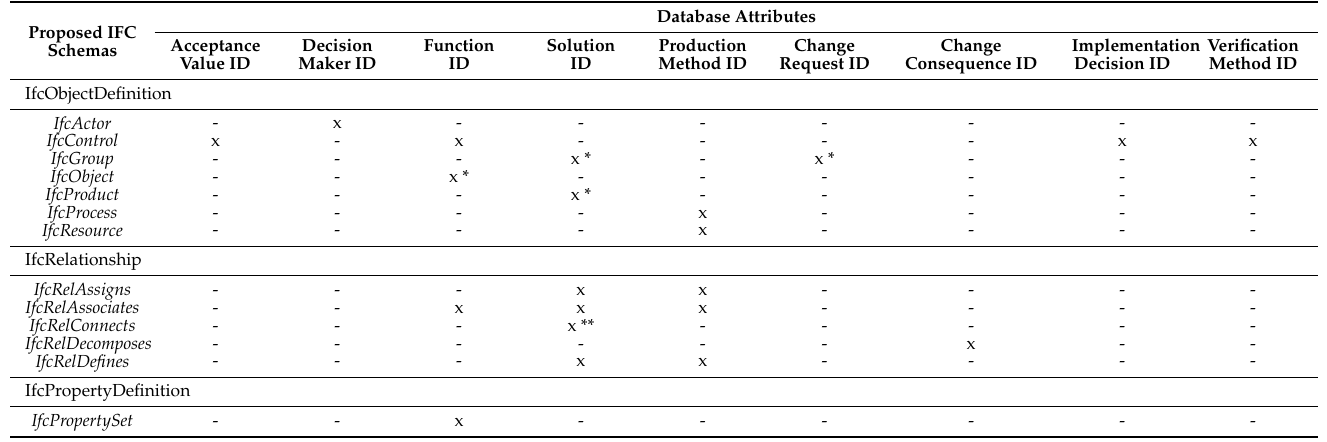
Table 3. The proposed IFC schemas for each attribute in the ER model and the ones used for exchanging flooring data in the studied